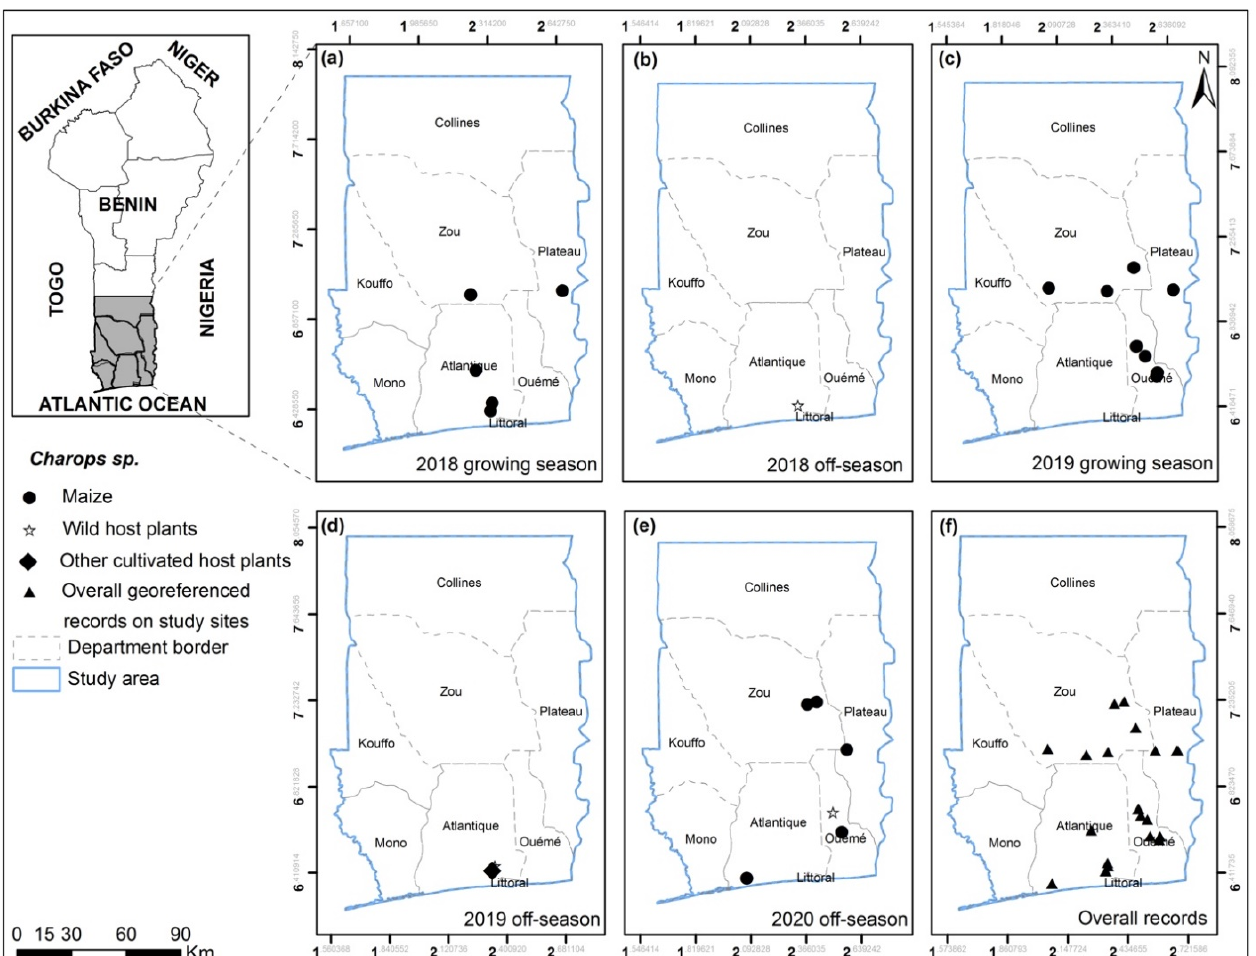
Figure 4. Charops sp. georeferenced records on maize, wild and other cultivated host plants for the years 2018, 2019 and 2020 on the study sites for growing ( a , c ) and off-seasons ( b , d , e ) in southern and central Benin ( f ).